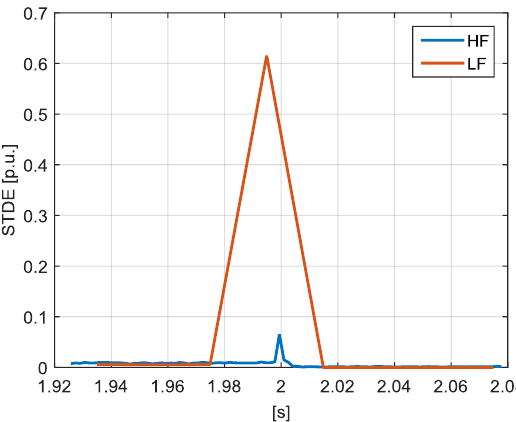
( b ) low-frequency waveform and ( c ) high-frequency waveform.